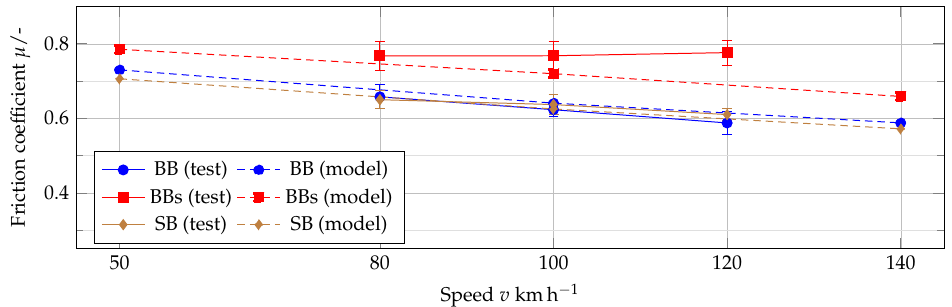
Figure 20. Comparison of the wet grip model with the measurement results at 1mm water level on asphalt.